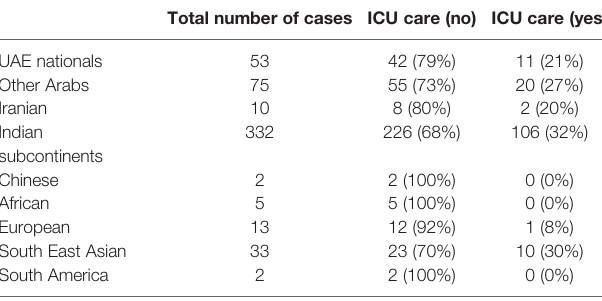
Data presented as number (%). P value 0.24.